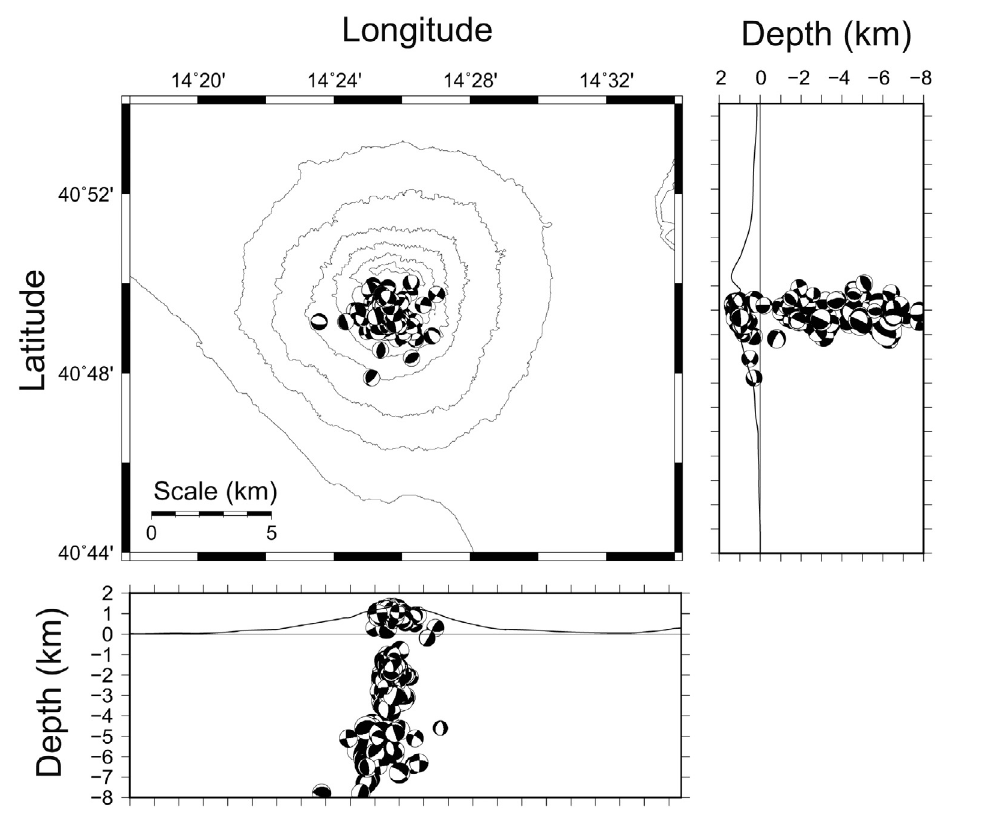
Figure 11. Focal mechanisms for 195 events. Beach-balls are projected on the horizontal plane (top left ), on a NS cross-section (top right) and on a EW cross-section